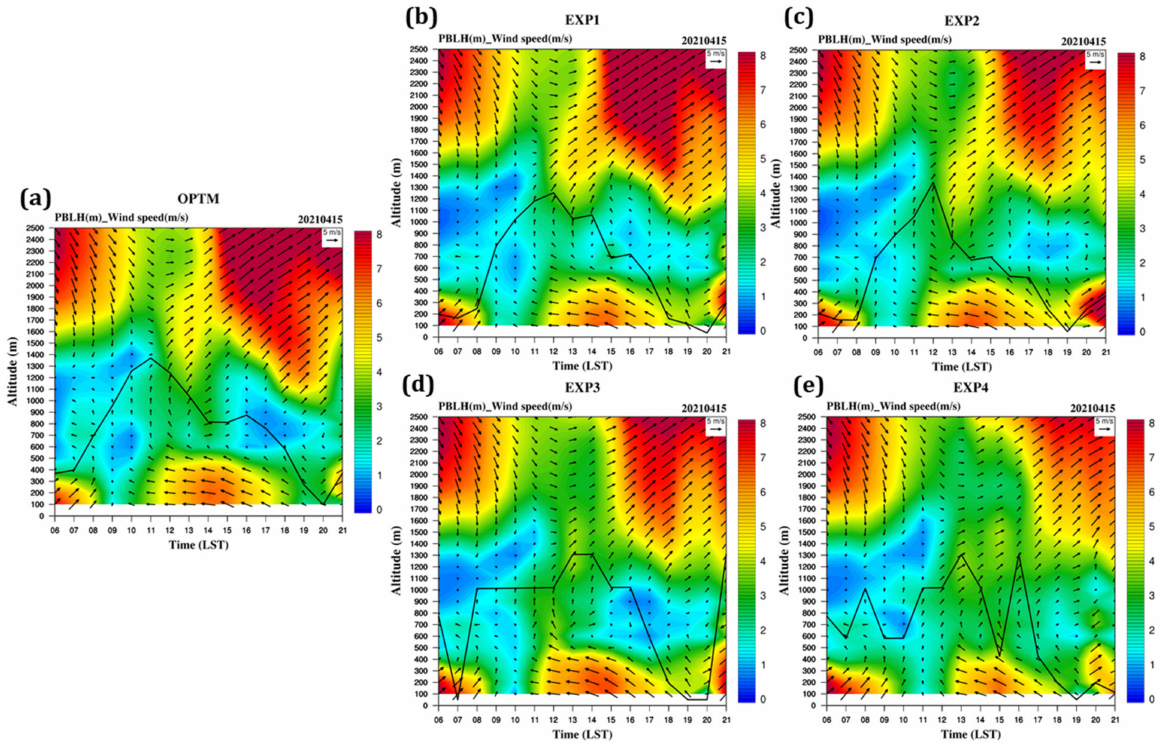
Figure 7. Time variation of PBL height (black line), horizontal wind speed (shading), and vector (arrow) on 15 April 2021. ( a ) OPTM, ( b ) EXP1, ( c ) EXP2, ( d ) EXP3, and ( e )